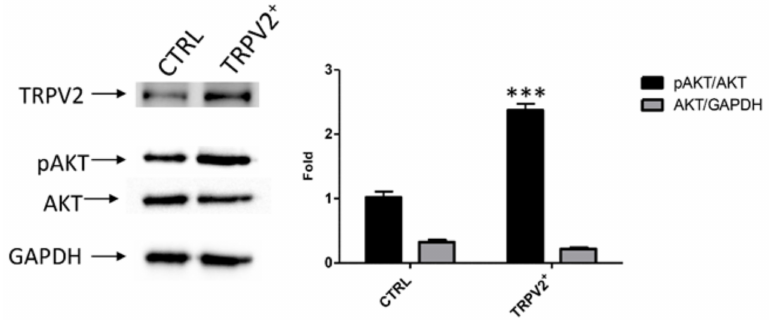
TRPV2 over-expression increased phosporilated form of AKT (pAKT) in EC cells. Representative Western blot analysis of pAKT(Ser473), AKT and GAPDH protein levels in TRPV2 + cells. The pAKT(Ser473) protein levels were determined with respect to AKT levels. AKT densitometry values were normalized to GAPDH used as loading control. Densitometric values shown are the mean ± SD of three separate experiments. *** p < 0.001 vs. control cells.